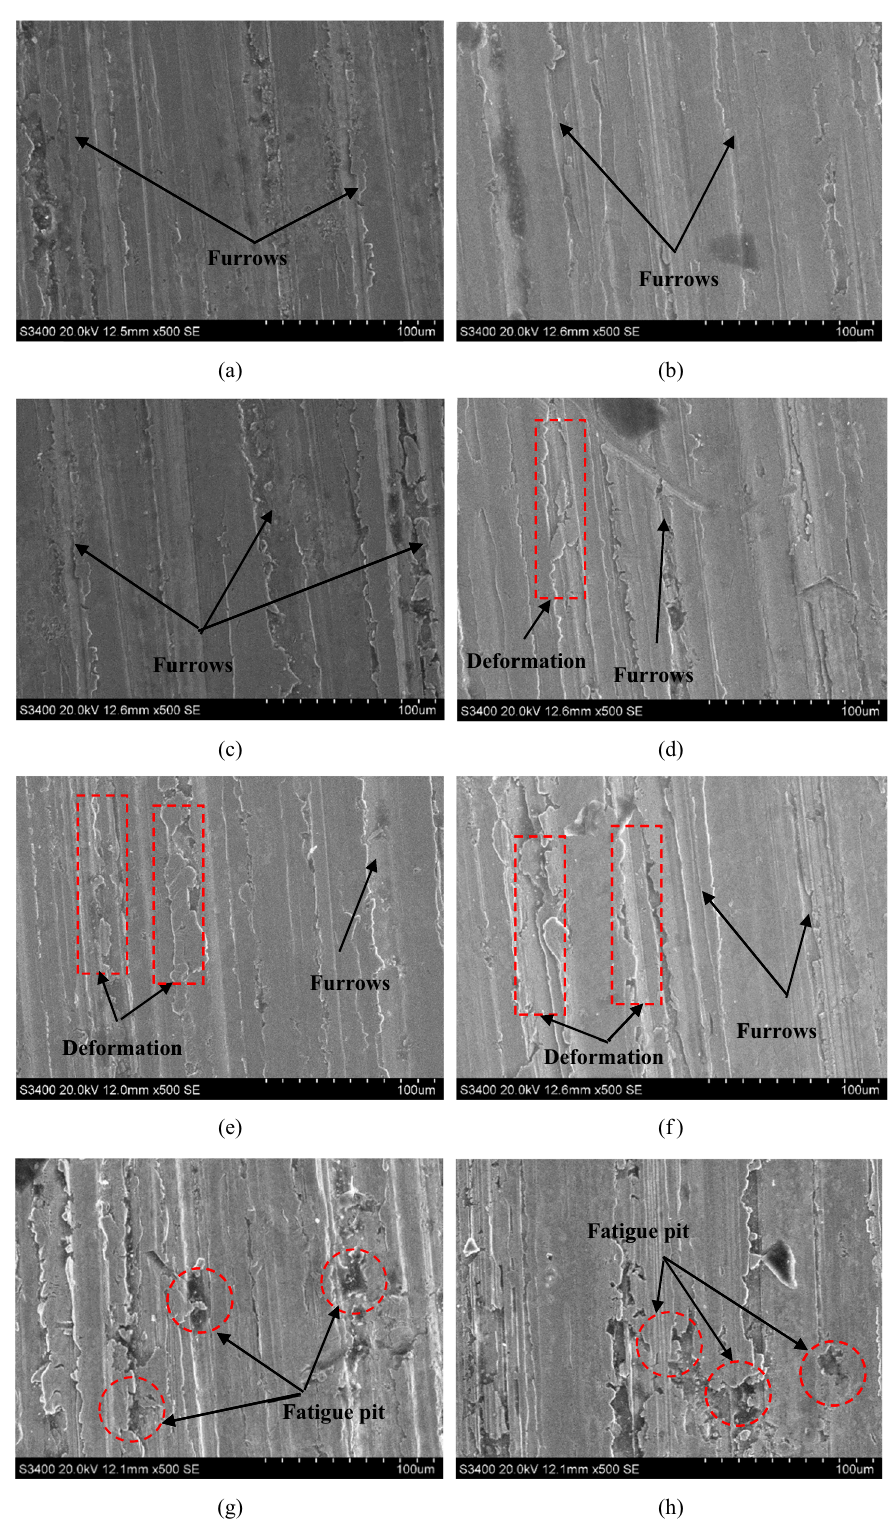
Figure 8: E ff ect of composite factors on the wear morphology of